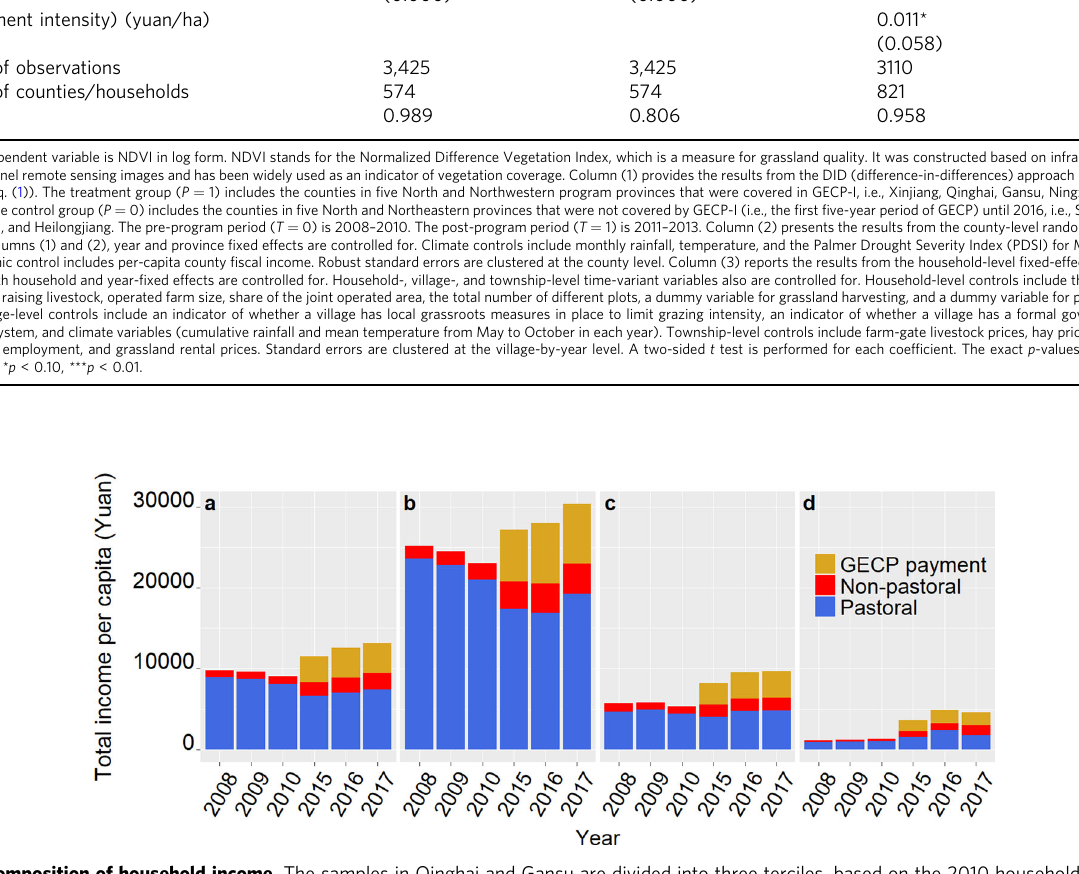
Fig. 2 Decomposition of household income. The samples in Qinghai and Gansu are divided into three terciles, based on the 2010 household income per capita. a Total income per capita for the whole sample in Qinghai and Gansu; b total income per capita for high-income group; c total income per capita for middle-income group; d total income per capita for low-income